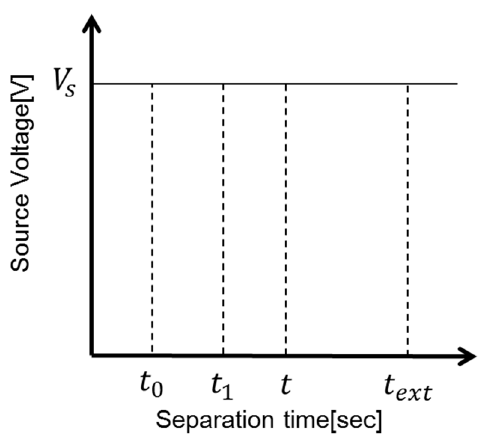
Figure 4. Source voltage.